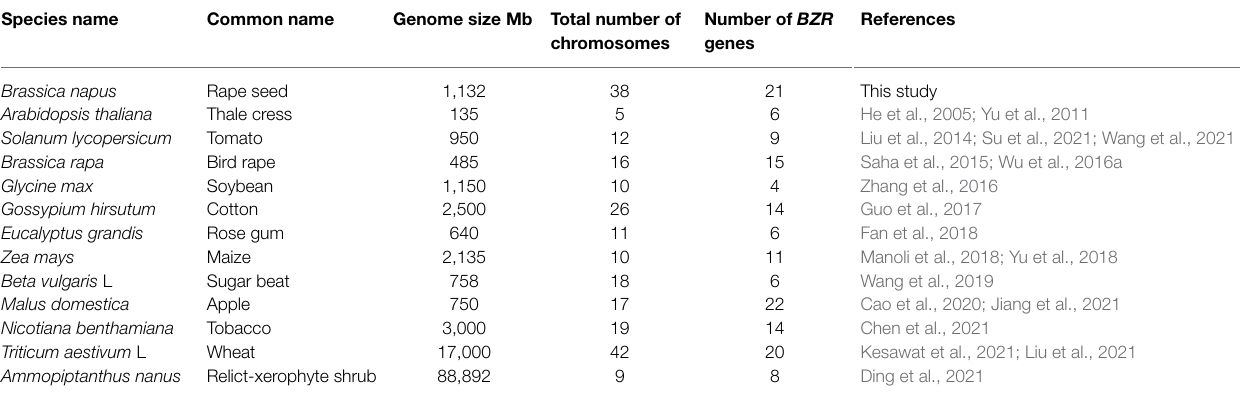
TABLE 1 | Number of BZR genes in Brassica napus and other plant